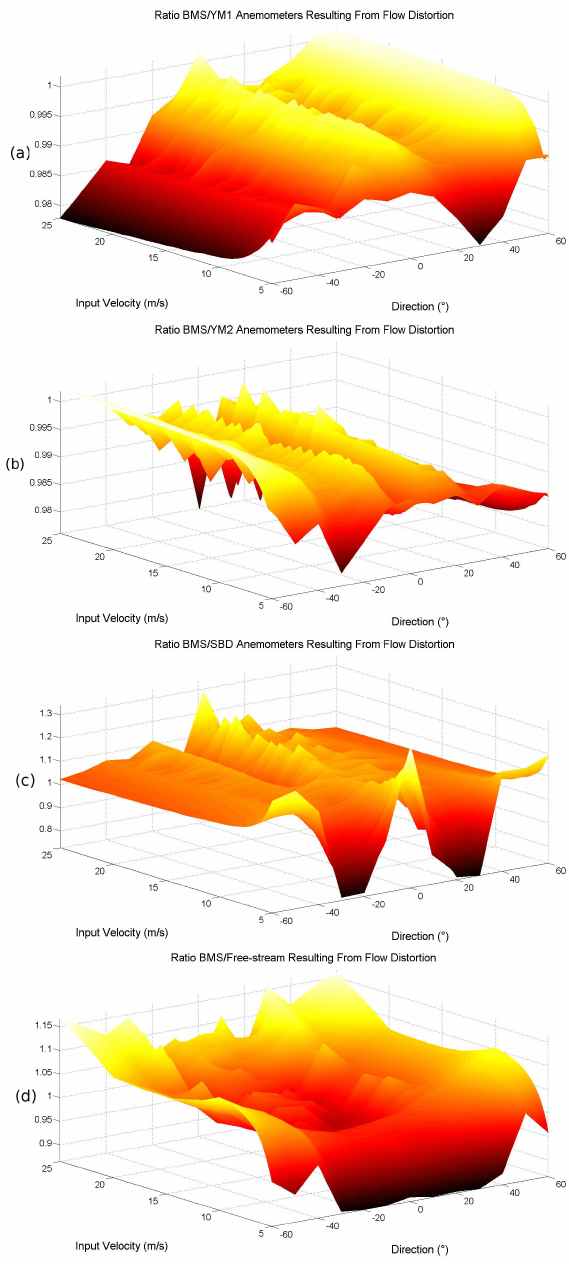
Fig. 7. Surface plot corrections for ratios between (a) BMS and YM1 starboard, (b) BMS and SBD, (c) BMS and YM2 port anemometer (d) BMS and free-stream velocity.